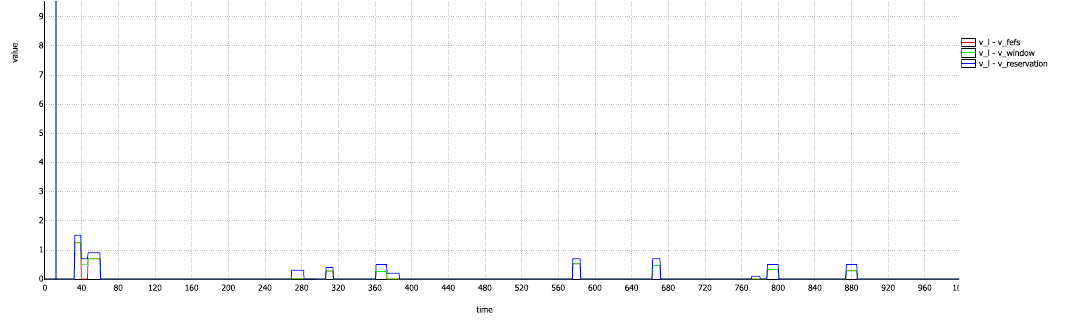
Figure 8. Difference of other velocities from V lane